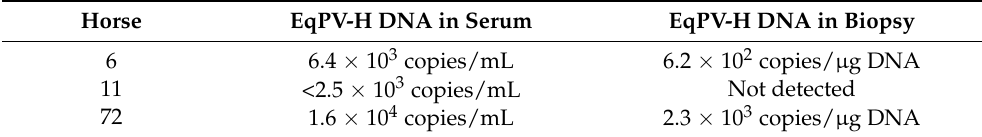
Table 2. DNA copy numbers in liver biopsy samples from horses 6, 11, and 72.